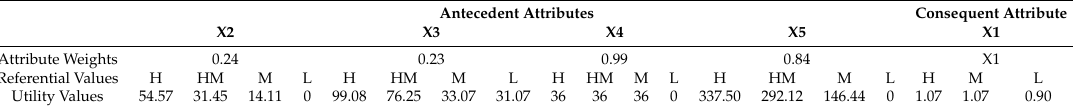
Table 11. Trained structure of the disjunctive BRB for the Antecedent and Consequent part.